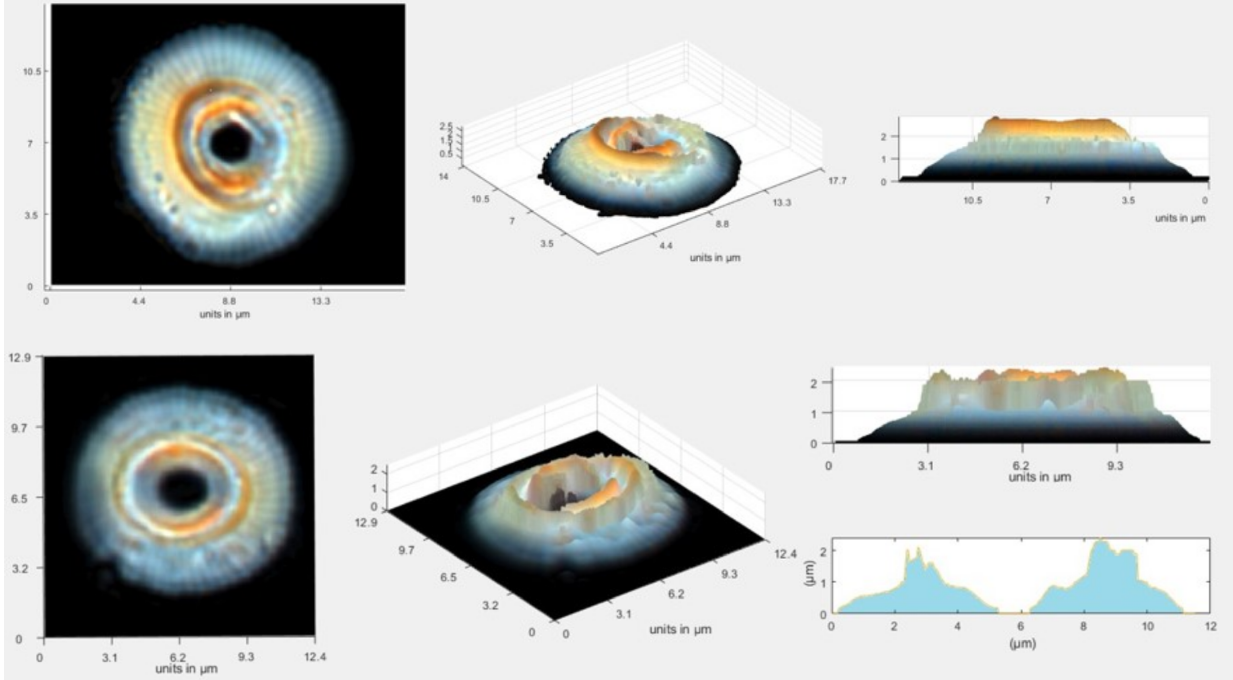
Figure 3. Schemes of large Reticulofenestra, which represent the original image of the coccoliths and example reconstructions of total calcite thickness accumulated across the